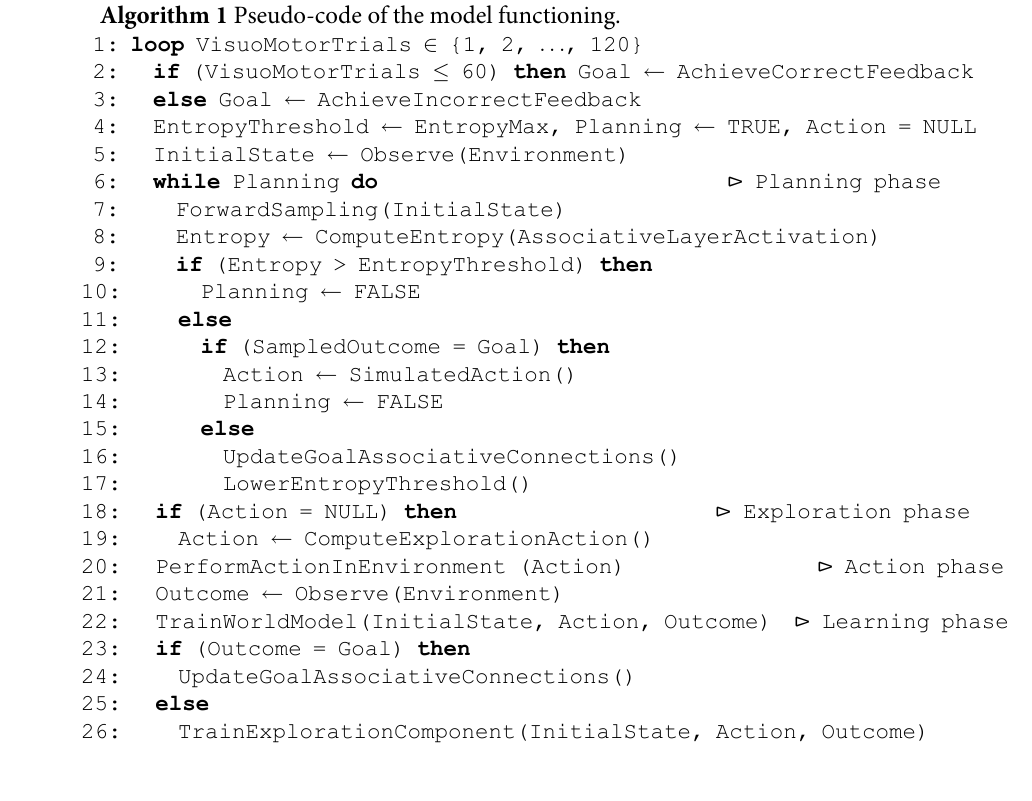
Algorithm 1 Pseudo-code of the model